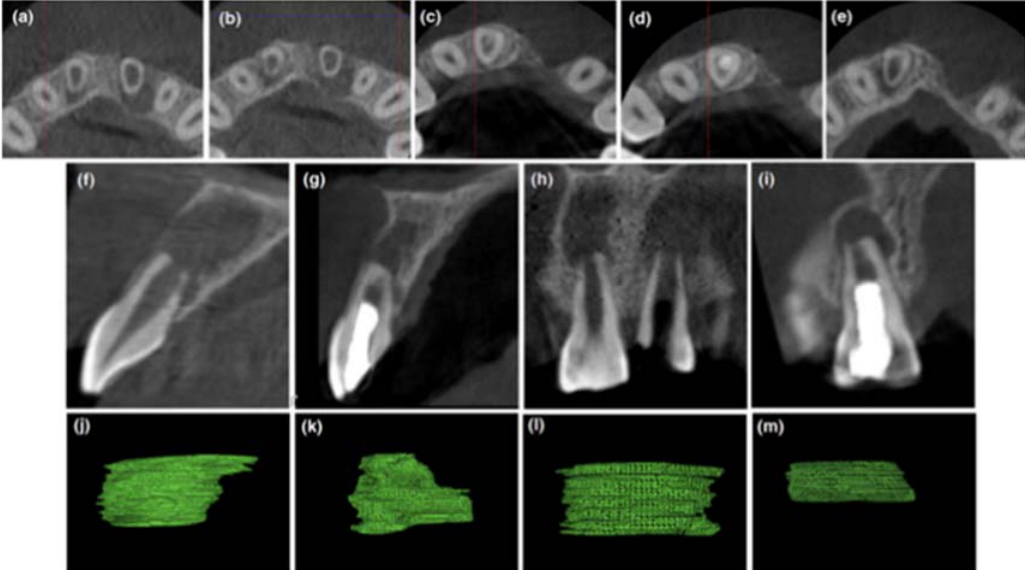
Figure 2. CBCT images of preoperative and three ‐ year follow up of REP in 11. ( a , b ) pre ‐ operative axial view revealing root canal dentin thickness and periapical radiolucency at midroot level ( a ) and apical section ( b ); ( c – e ) post ‐ operative axial view in the middle and apical region revealing a reduction in size of periapical radiolucency, thickening of root canal wall and mineralized layer above the Biodentine ( e ); ( f , g ) pre ‐ operative and post ‐ operative sagittal view showing a reduction in periapical radiolucency; ( h , i ) pre ‐ operative and post ‐ operative coronal view showing a reduction in periapical radiolucency and a thickening of the root canal wall; ( j , k ) pre ‐ operative and post ‐ operative axial images showing a reduction in volume of periapical lesion by 86% (measured using Volux—Horos viewer for Mac (V2.0.2); ( l , m ) pre ‐ operative and post ‐ operative sagittal images showing a reduction in volume of periapical lesion by 78% (measured using Volux—Horos viewer for Mac (V2.0.2).